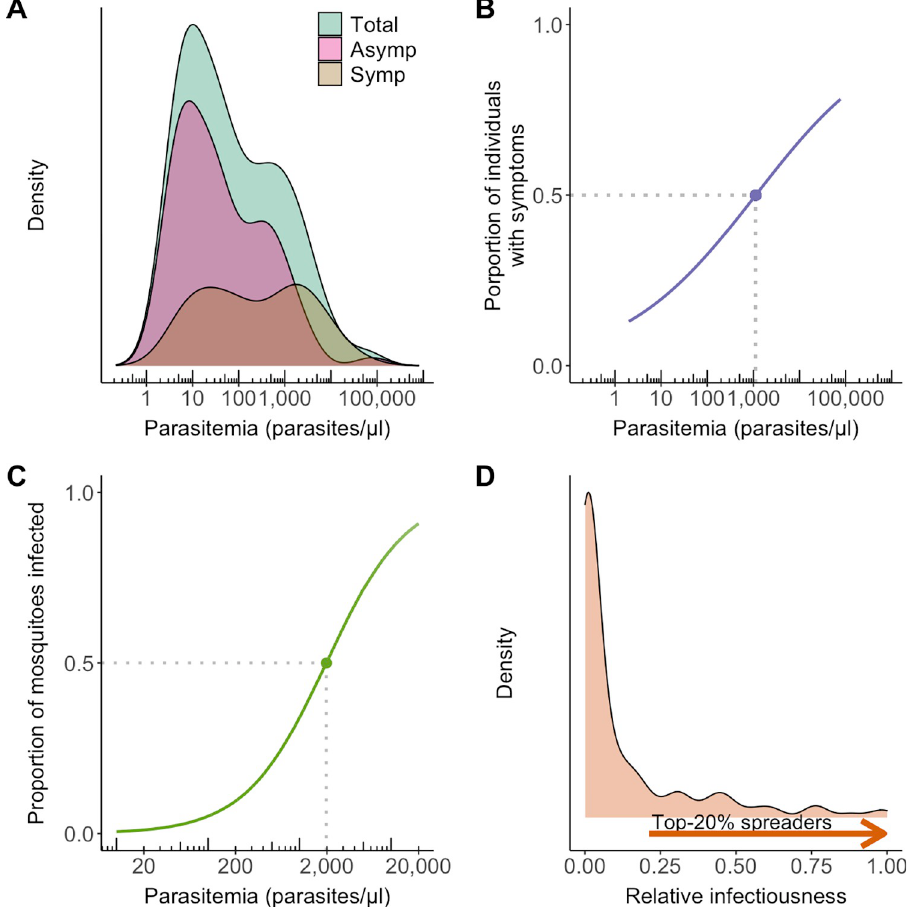
Fig 2. How blood-stage parasite density relates to the risk of clinical manifestations and human-to-mosquito transmission of Plasmodium vivax . ( A ) Distribution of parasite densities measured by quantitative PCR in symptomatic (“Symp”) and asymptomatic (“Asymp”) P . vivax infections. ( B ) Association between P . vivax blood-stage density and the risk of clinical symptoms (fever or headache) within 7 days prior to detection of blood-stage infection, with > 50% of the individuals being symptomatic above 1,100 parasites/ μ L. ( C ) Association between total P . vivax blood-stage density and the probability of Anopheles darlingi infection in standard membrane feeding assays, with 50% of the mosquitoes being infected at approximately 2,000 parasites/ μ L, assuming that 15% of circulating parasites are mature gametocytes. ( D ) Relative infectiousness of infected individuals in the community. We combine individual estimates of relative infectiousness of P . vivax carriers in the community. Most infected people are little infectious (relative infectiousness close to zero), but the top 20% spreaders are estimated to account for nearly 80% of all transmission events. Data from a farming settlement in the Amazon Basin of Brazil [63]. Figures redrawn from [59].